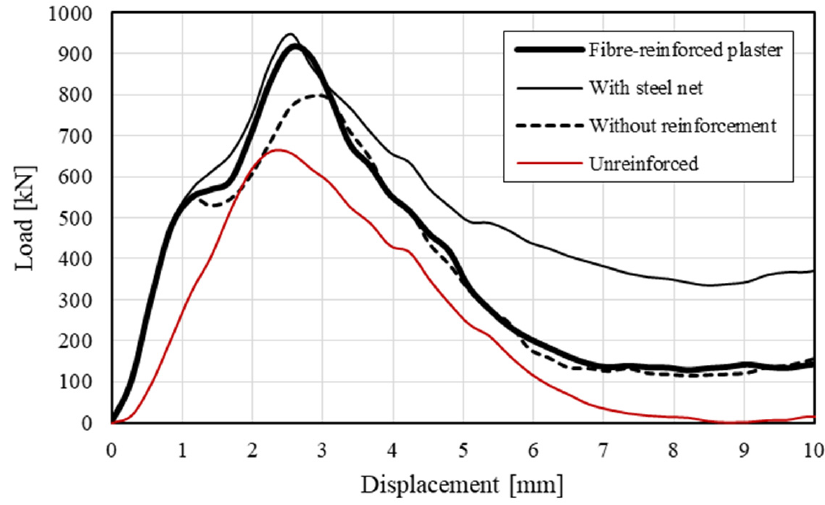
Figure 23. Load–displacement curves without reinforcement, with steel-net reinforcement and with fiber-reinforced plaster.